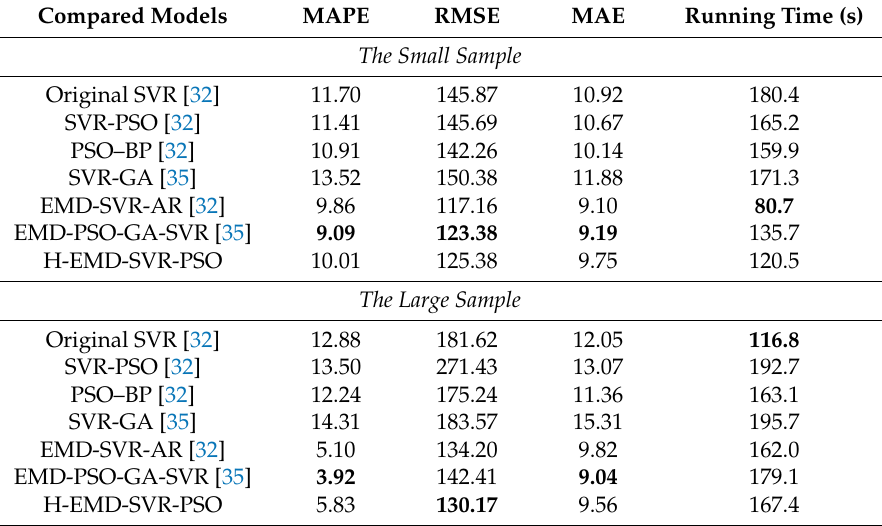
Table 3. Summary of results of the forecasting models.